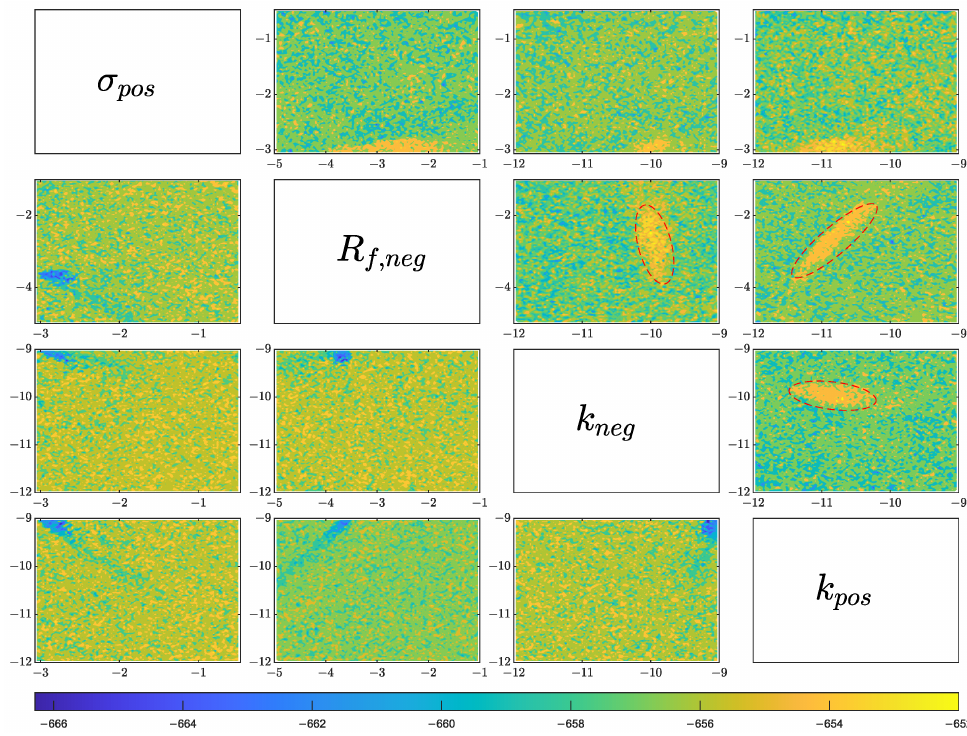
Figure 7. Two-dimensional plot of the objective function value for case 1 (upper triangular) and case 2 (lower triangular). For case 1, an obvious correlation can be observed between the film resistance and the anodic reaction rate constant, film resistance and the cathodic reaction rate constant, and anodic reaction rate constant and cathodic reaction rate constant. For case 2, no correlation pattern can be